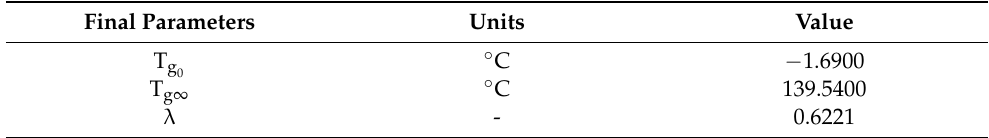
Figure 4. The measured and predicted glass transition temperatures for OM12. Table 2. Glass transition temperature model